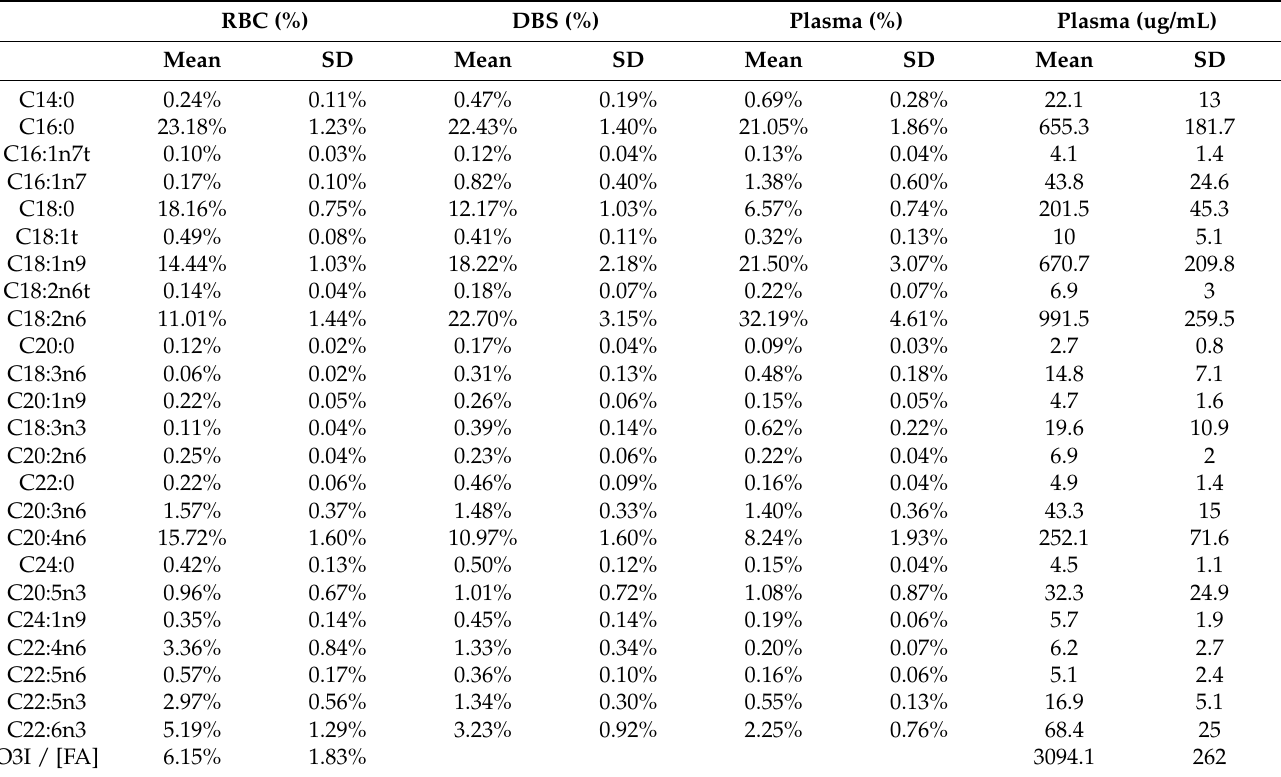
Table 4. Fatty acid composition of red blood cells, dried blood spots, and plasma (both as a percent of total fatty acids and as concentrations) from 100